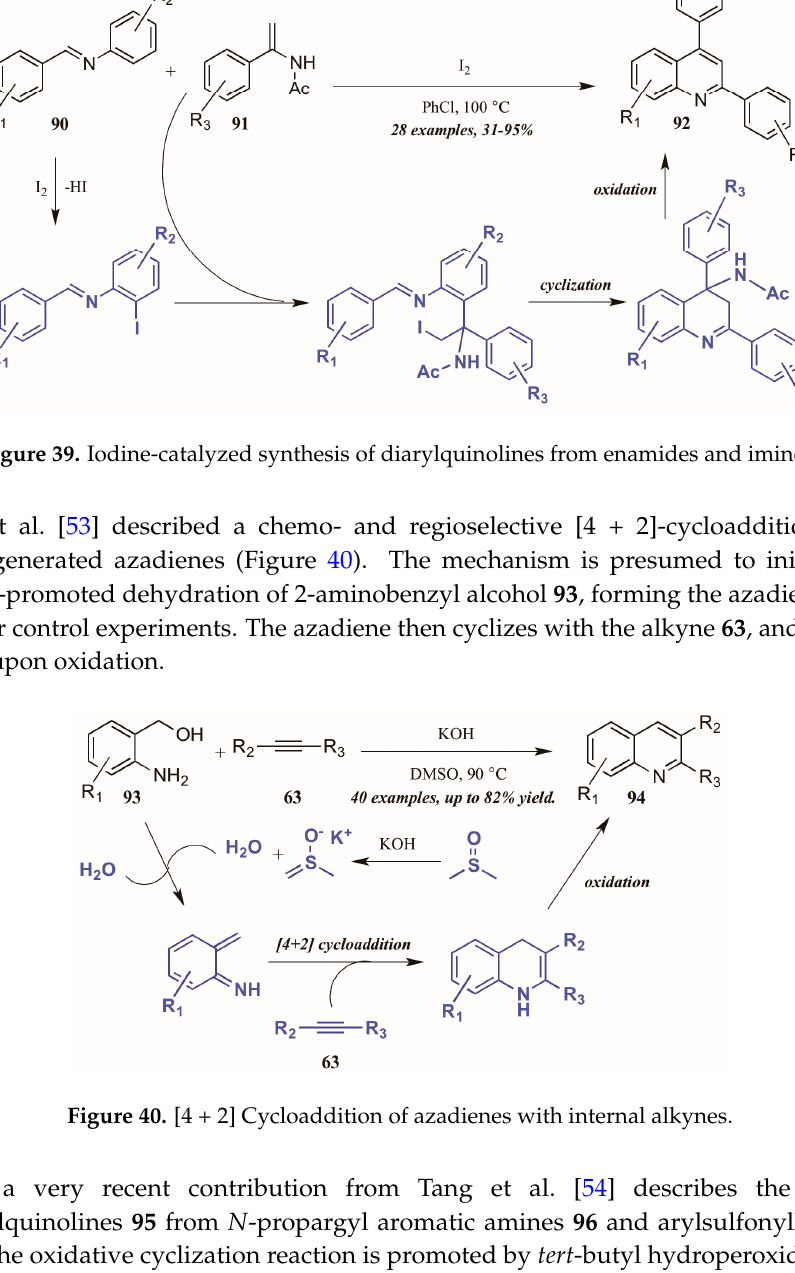
Figure 38. NBS-mediated radical cyclization to form 3-substituted quinolines.